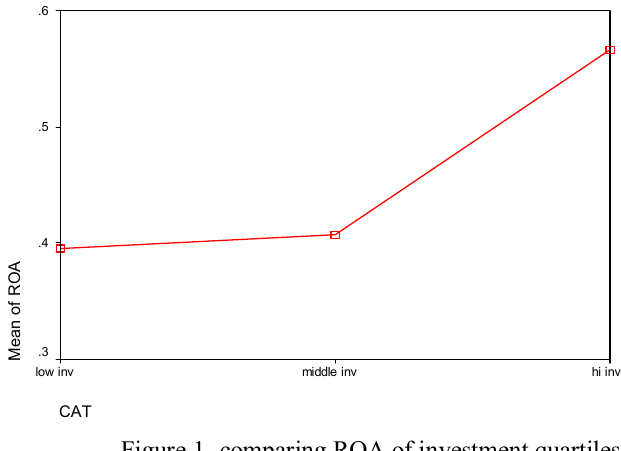
Figure 1- comparing ROA of investment